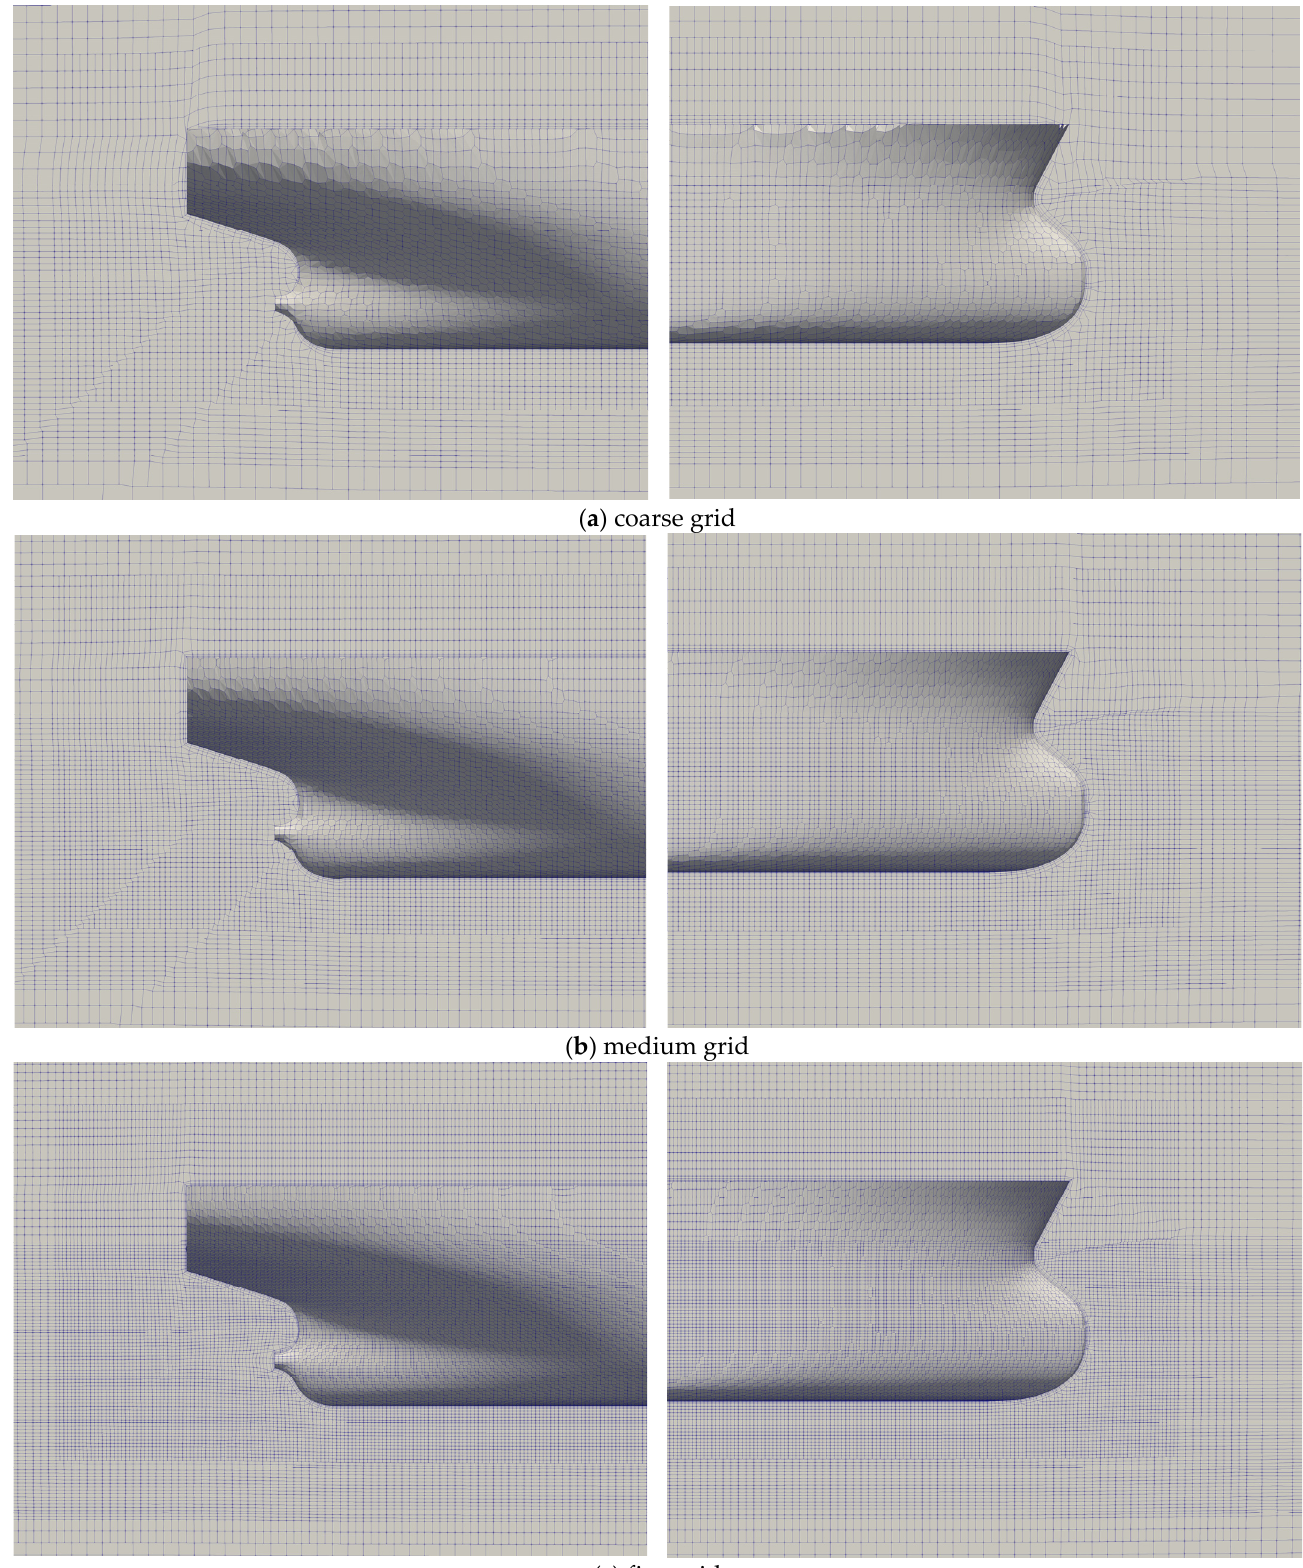
Figure 5. Local grid distribution. ( Left ): ship stern; ( right ): ship bow.